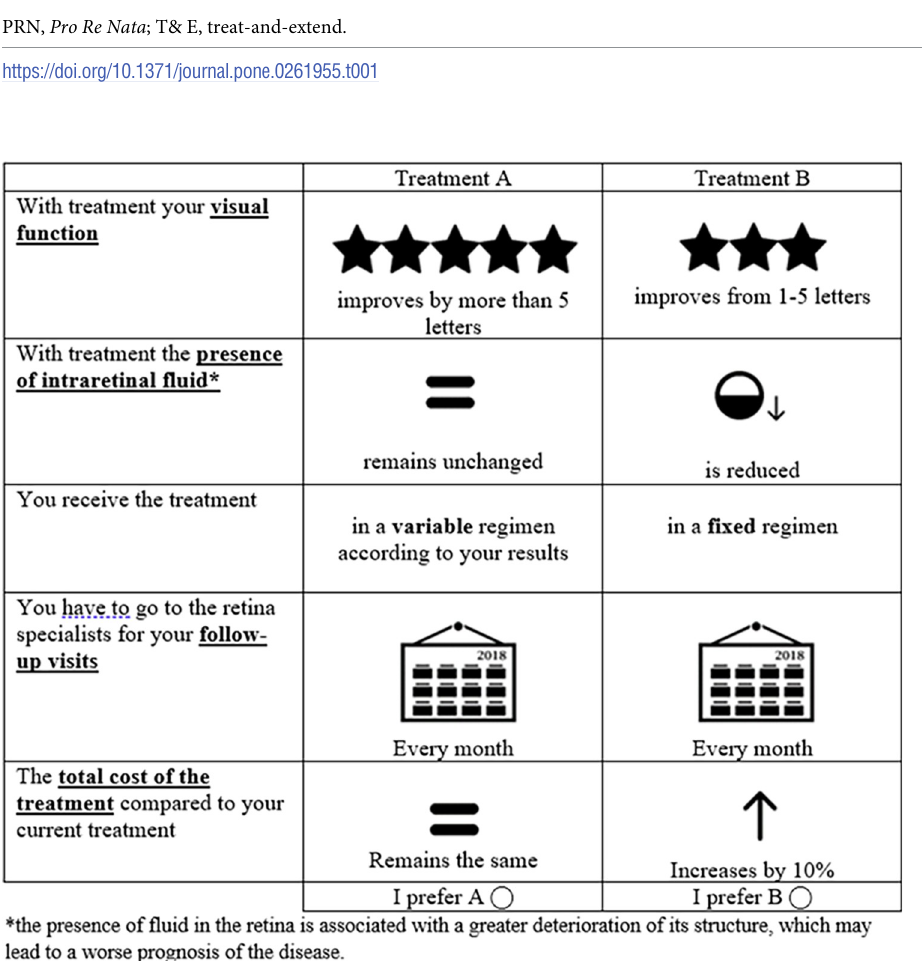
Fig 1. Example of hypothetical choice sets presented to